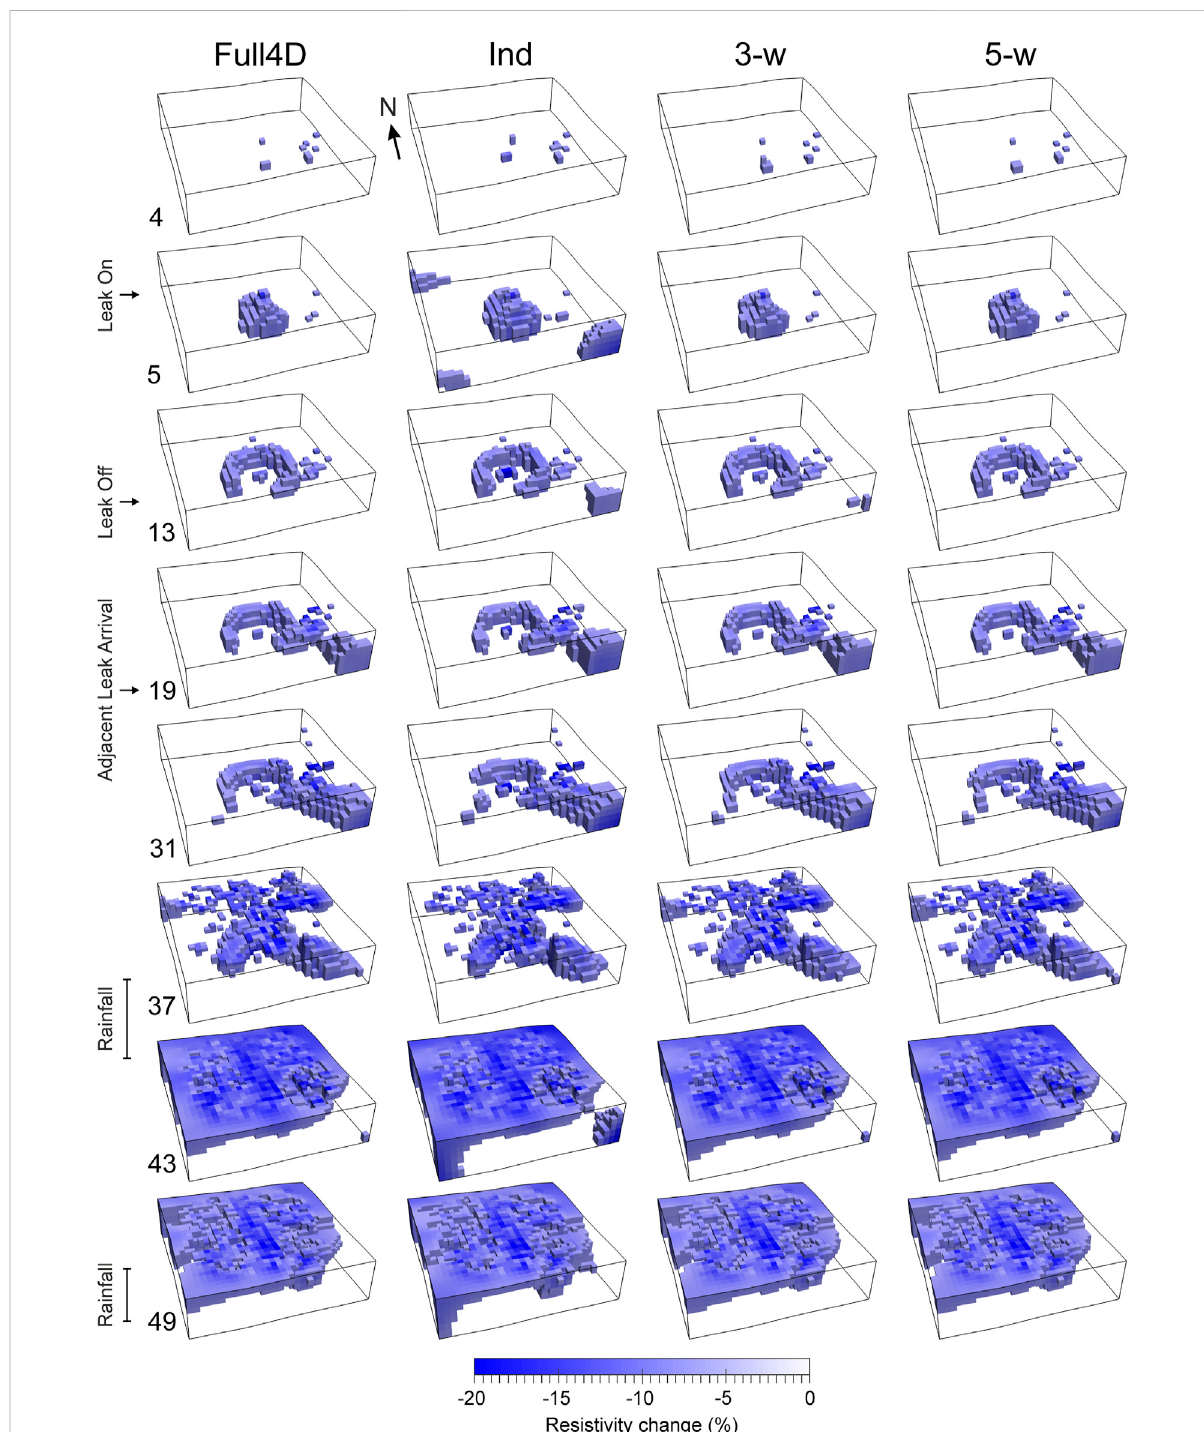
FIGURE 12 Distributionsoffractionalresistivity changeatSite 3for thefullsequence 4D, independent,and windowedinversionsatthetimestepsindicated on the left-hand side. Only model cells with resistivity changes below − 20% are